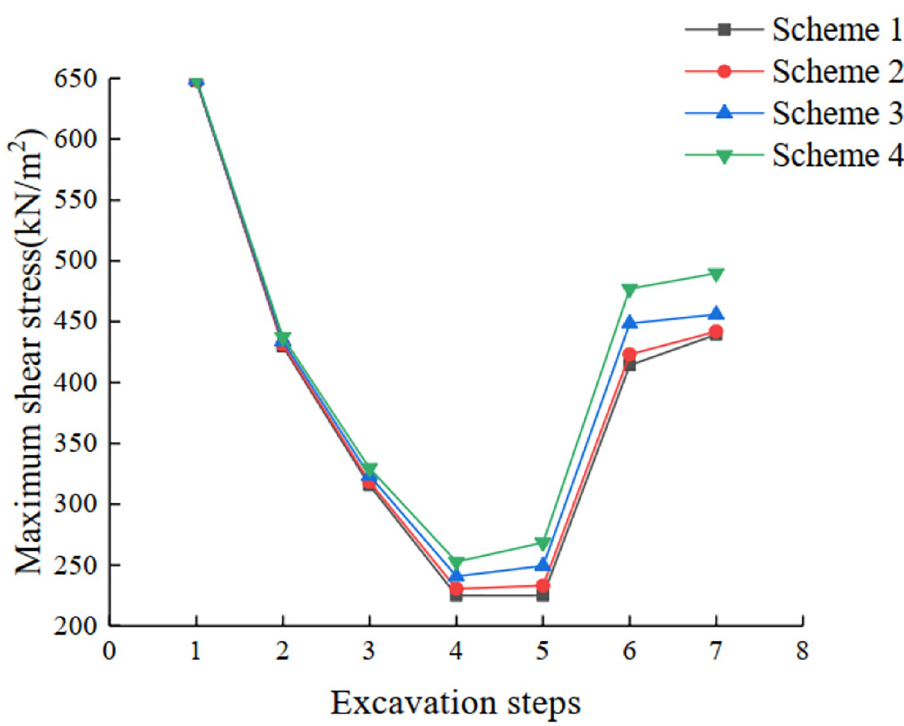
Fig 15. Curves of maximum shear stress in different experimental schemes.